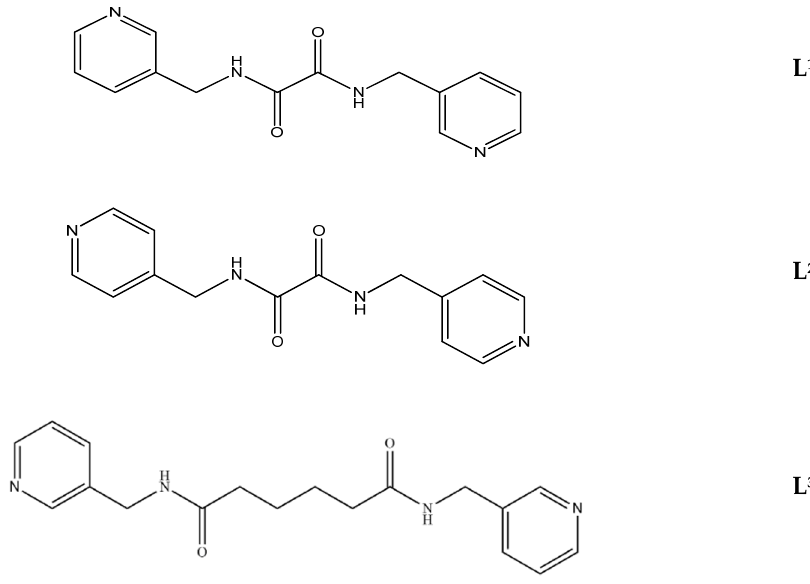
Figure 1. Structures of the ligands L 1 – L 3 .